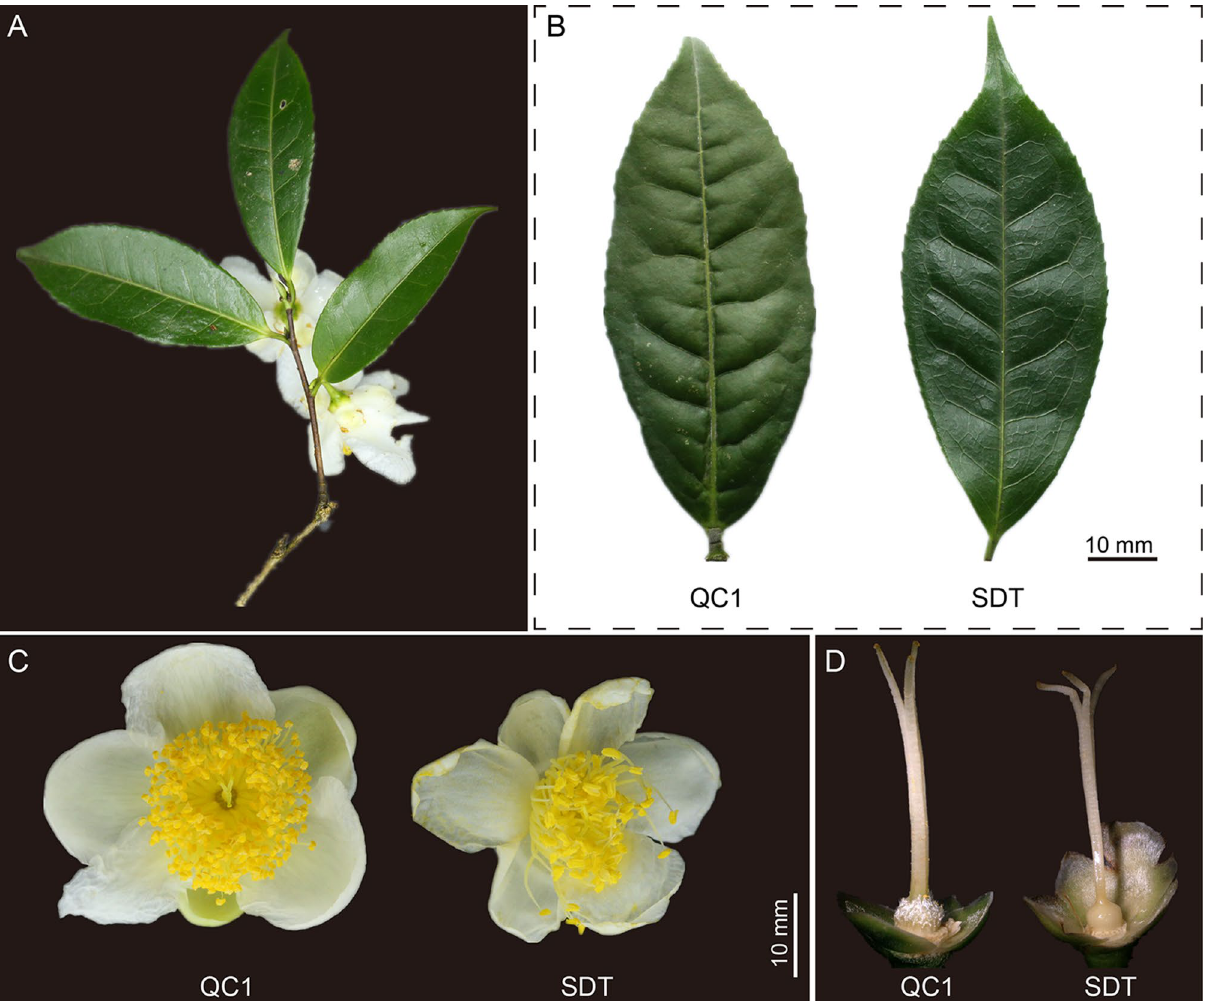
Figure 1. Morphological characteristics of ‘Qiancha 1’ and SDT. ( A ) SDT tea plant contains leaves, stem, and flowers. ( B ) Mature leaves of QC1 (left) and SDT (right). ( C ) Flower diameter of QC1 (left) and SDT (right). ( D ) Style and ovary of QC1 (left) and SDT (right). The image was taken by the author of this article without copyright